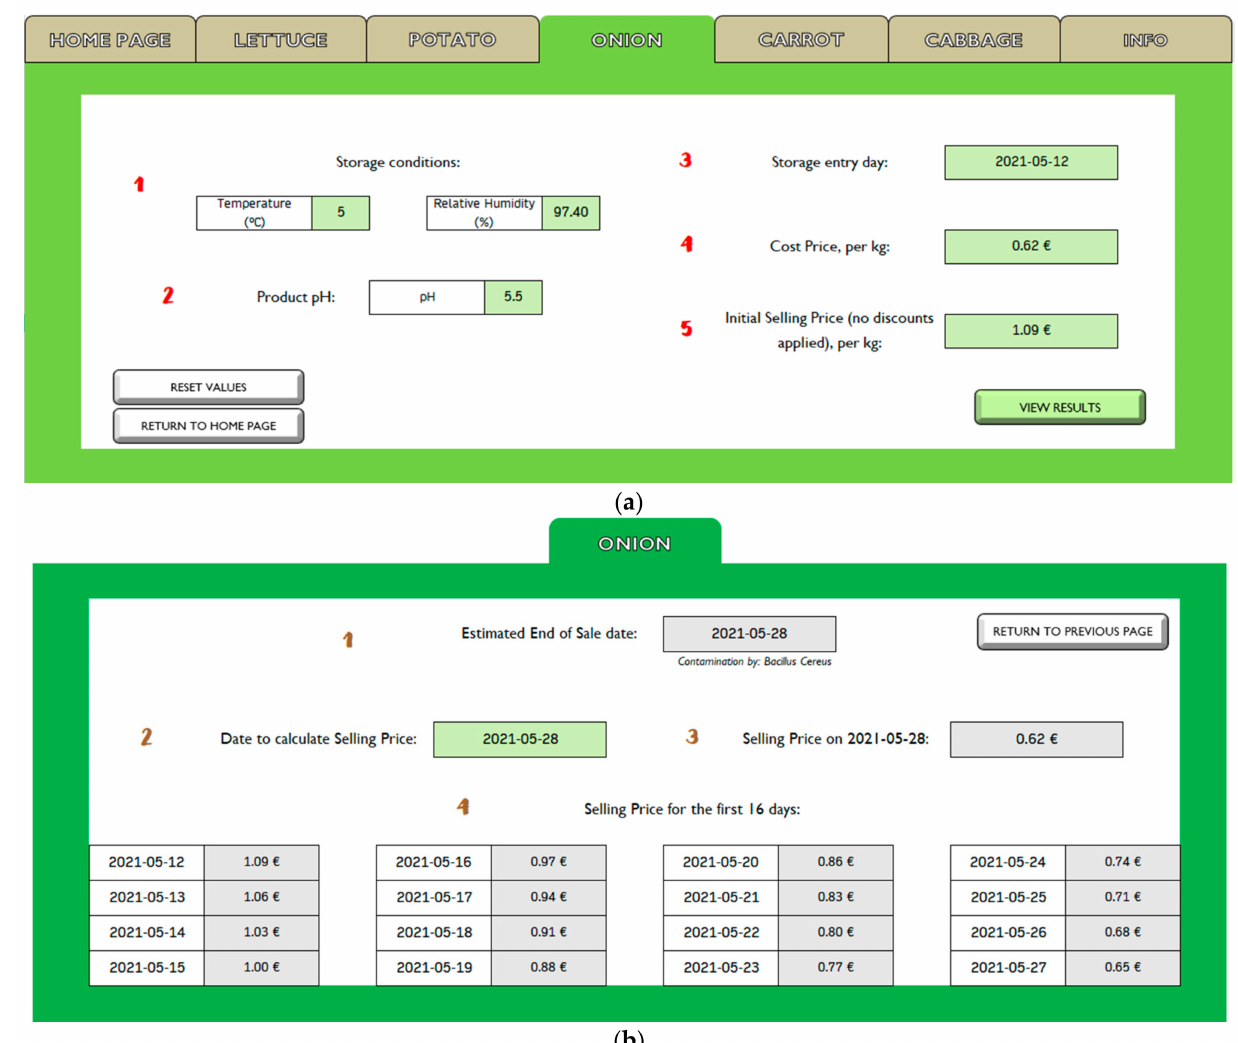
Figure 4. DSS user interface exemplified on onion: ( a ) Entering data regarding storage conditions and pricing; ( b ) Visualiza- tion of the obtained